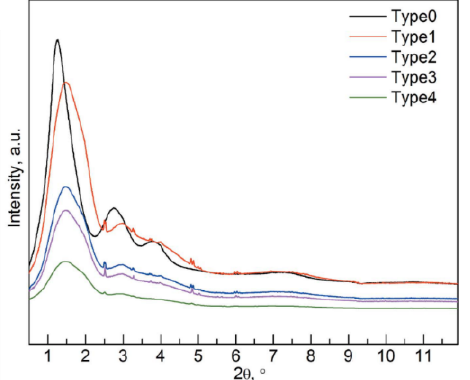
Figure 4. In situ X-ray synchrotron powder patterns of empty vessels show different background contributions depending on the material and wall thickness. Type 0: PMMA, Type 1 – 4: PLA. Minor diffraction peaks originate from a colorant in the PLA vessels. Reprinted with permission of [52]. Copyright 2017, International Union Of Crystallography.